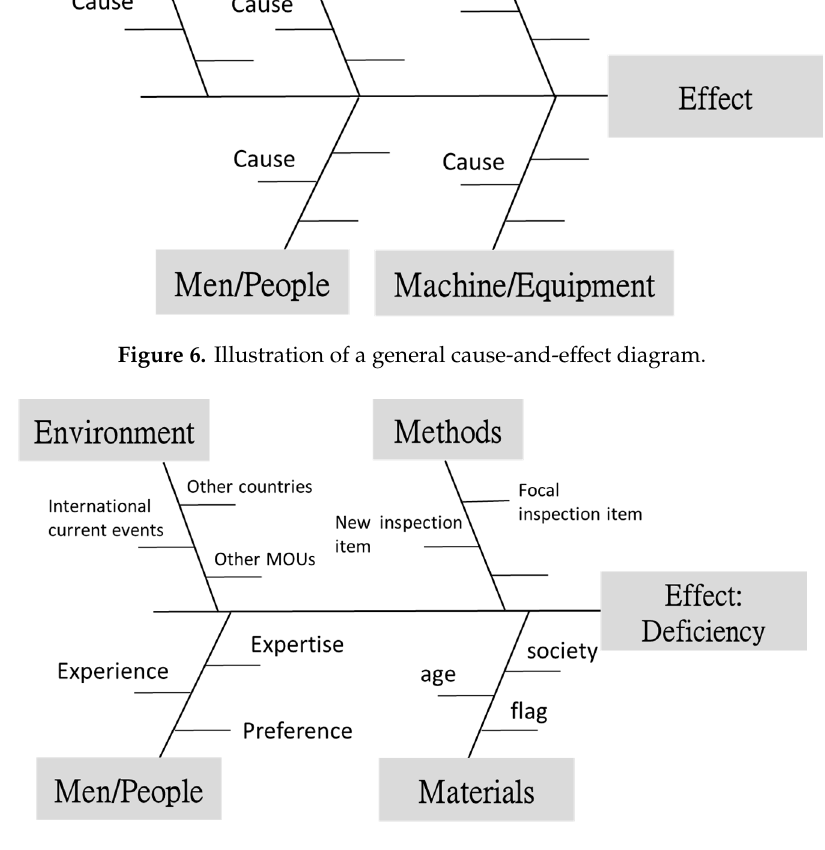
Figure 7. Illustration of a modified cause-and-effect diagram for PSC.